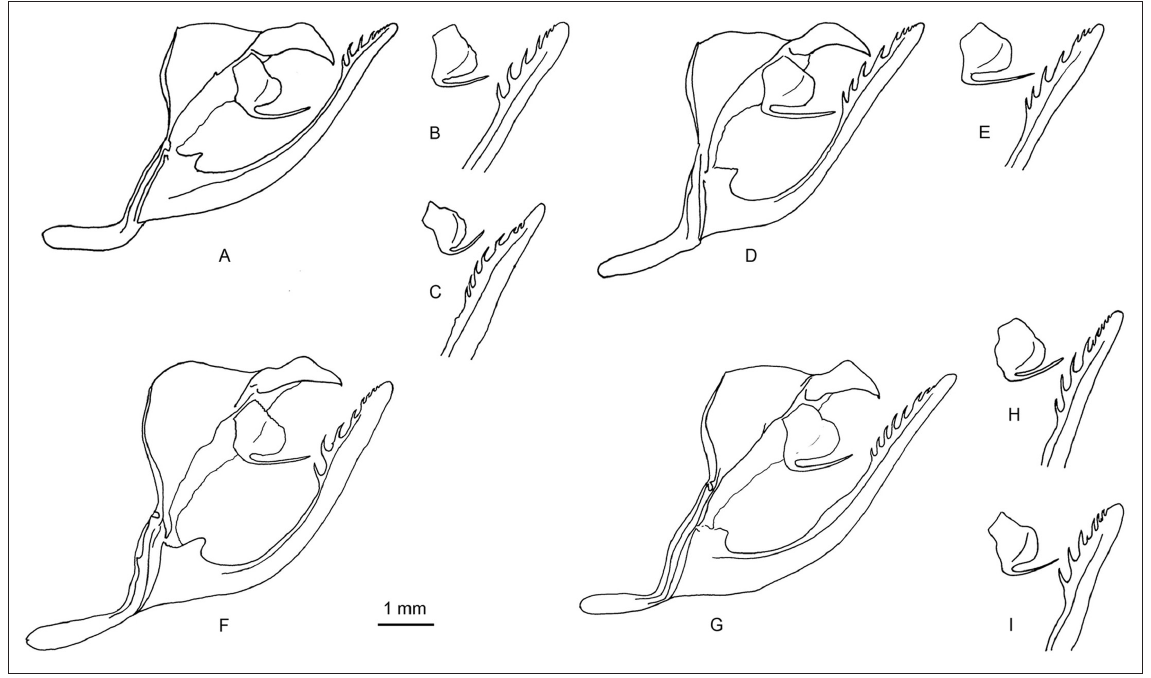
Fig. 13. A-C . Male genitalia of Eryphanis zolvizora greeneyi Penz & DeVries, 2008, stat. rev. A . Specimen from Rio Blanco, Ecuador (MNHN, PBB 729). B . Specimen from Rio Blanco, Ecuador (MNHN, PBB 537). C . Specimen from Rio Blanco, Ecuador (MNHN, PBB 257). – D-F . Male genitalia of Eryphanis zolvizora casagrande ssp. nov. D . HT from Altaquer, Nariño, Colombia (ICNUN). E . PT from Ricaurte, Nariño, Colombia (IAvH; drawing by Jean-François Le Crom, JFL 336). F . Specimen from Las Gralarias, Pichincha, Ecuador (FLMNH). – G-I . Male genitalia of Eryphanis zolvizora opimus (Staudinger, 1887). G . Specimen from Manizales, Caldas, Colombia (BMNH 8228). H . Specimen from Arménia, Quindio, Colombia (MNHN, CG). I . Specimen from Pereira, Risaralda, Colombia (BMNH